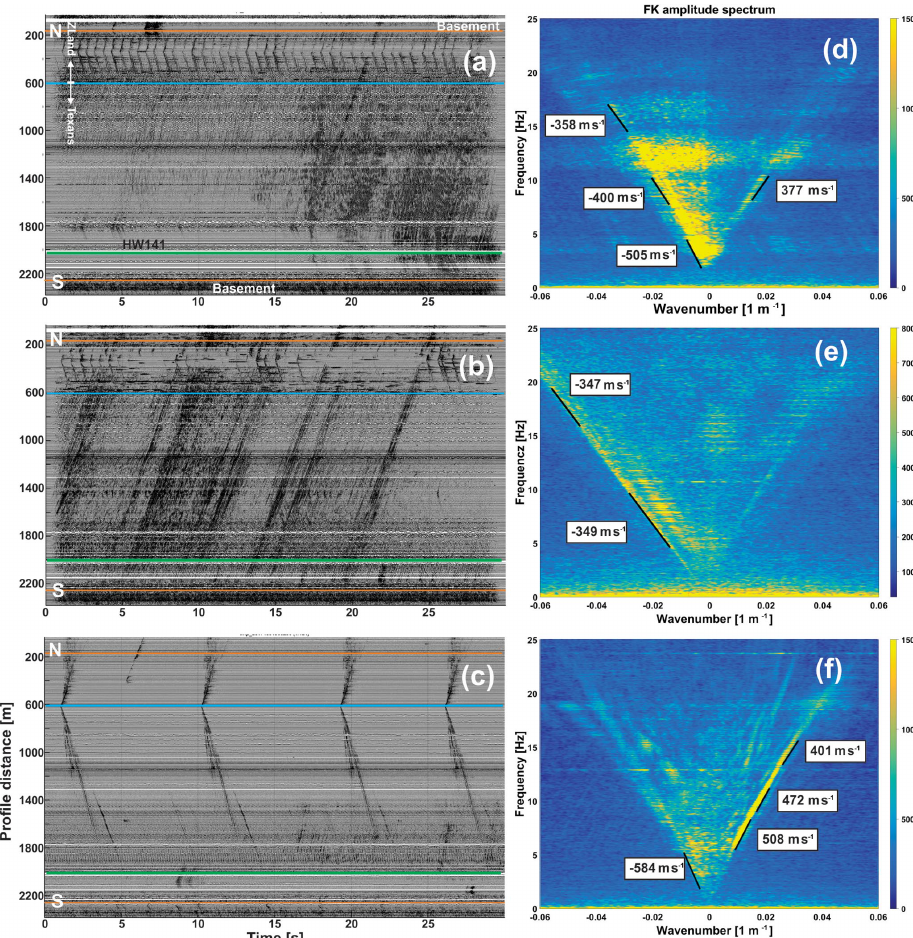
Figure 5. Three 30s long slices of continuous data (a–c) and their representation in the FK domain (d–f) . Traces are arranged horizontally from north (top) to south (bottom). Vertical axis: profile distance. The blue line discriminates ZLand 3C nodes (north) from Texan 1C geophones (south). Green line: highway 141. Measured slopes in the FK gathers represent group velocities. (a, d) Traffic and walking noise. (b, e) Passing thunderstorm. (c, f) Succession of several blasts from the A200